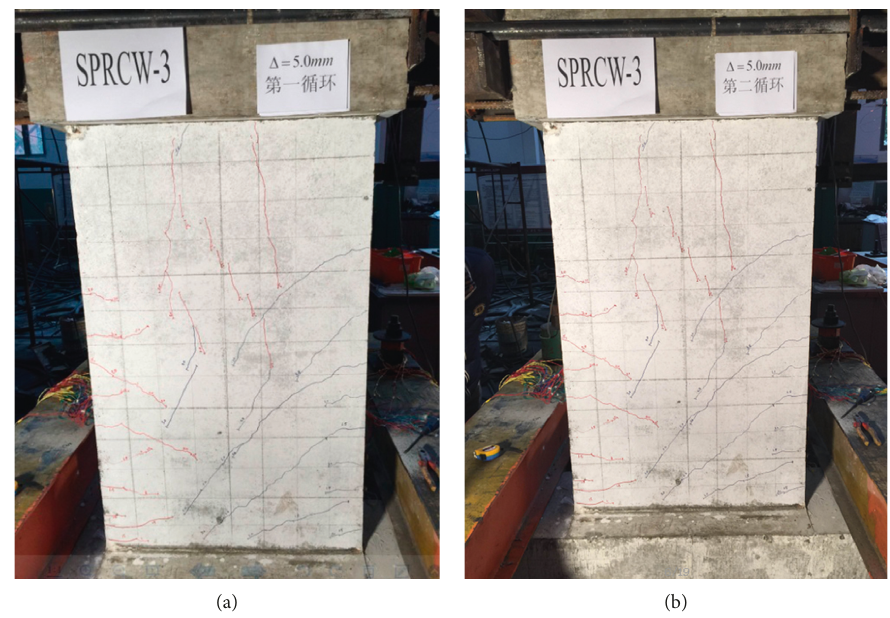
Figure 15: Diagram for cracks in the cycle with Δ � 5mm. (a) First cycle. (b) Second